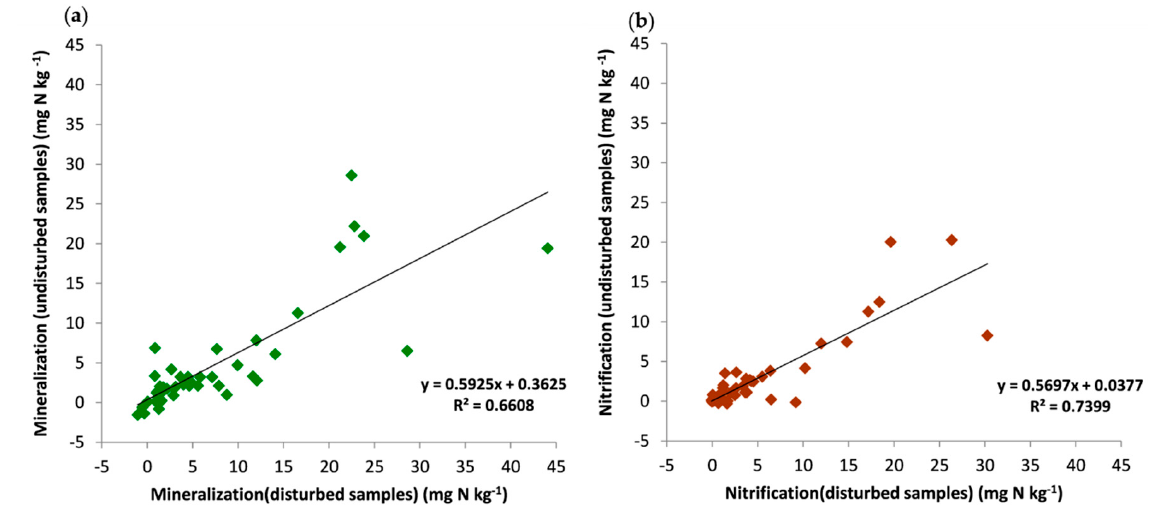
Figure 7. Linear relationships between disturbed and undisturbed samples for bimonthly N mineralization ( a ) and nitrification rates ( b ).